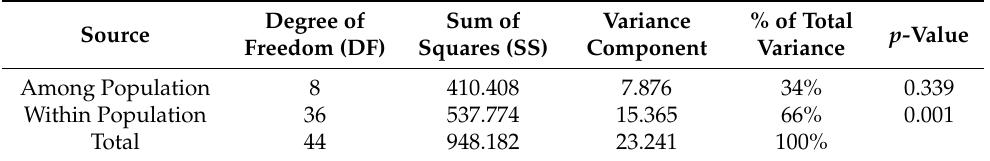
Table 6. Analysis of molecular variance (AMOVA) among and within the bean genotypes, using SSR marker. Degree of Sum of Source